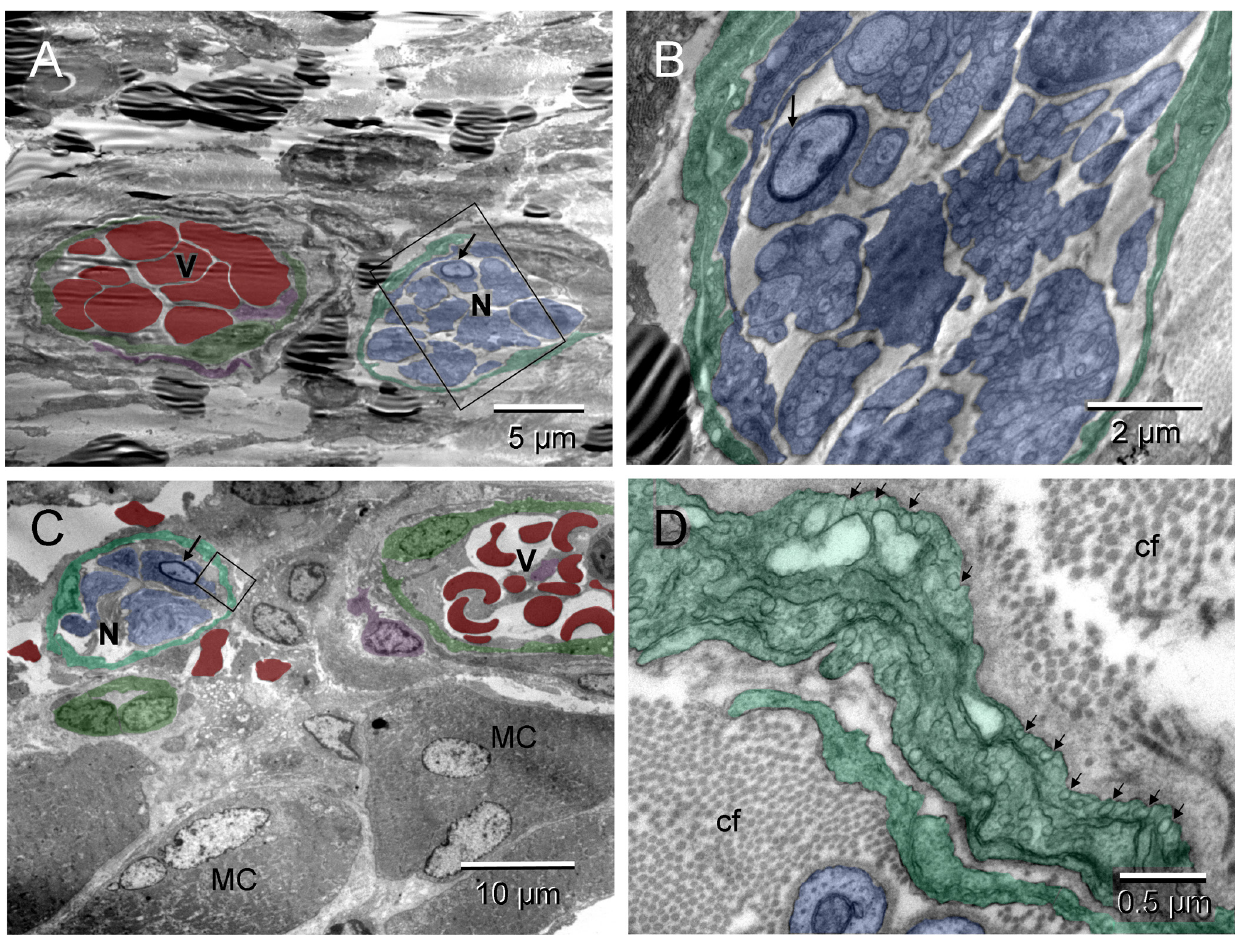
Figure S4. Coordinated morphogenesis of blood vessels (V) and peripheral nerves (N). Two neuro-vascular pairs. The upper pair was less mature; the boxed area of the nerve (blue) in [ A ] (enlarged in [ B ]) showed incomplete myelination of the neuron (arrows). The pair located next to the muscle cells (MC) [ C ] appeared more mature; the myelination of one neuron was completed (arrow). Morphology of the erythrosomes (red) surrounded by endothelium (green) was also more mature in [ C ]. The boxed area, enlarged in [ D ], featured abundant caveolae (arrows) of the multilayered neurothelium (emerald) and difference in thickness of the collagen fibers (cf) between those in endoneurium (thinner) and in surrounding ECM (thicker) [ D ].